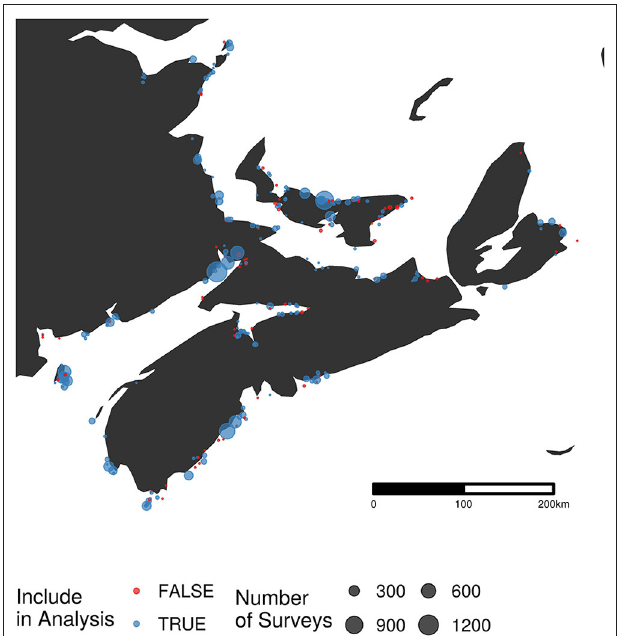
FIGURE 3 | Number of years surveyed and the number of surveys per year for each location. The color of the point is the safety index (i.e., proportion of the site within 150 m of cover; see Methods). The two largest sites are named. Figure S1 shows results of sensitivity analysis around the importance of these two